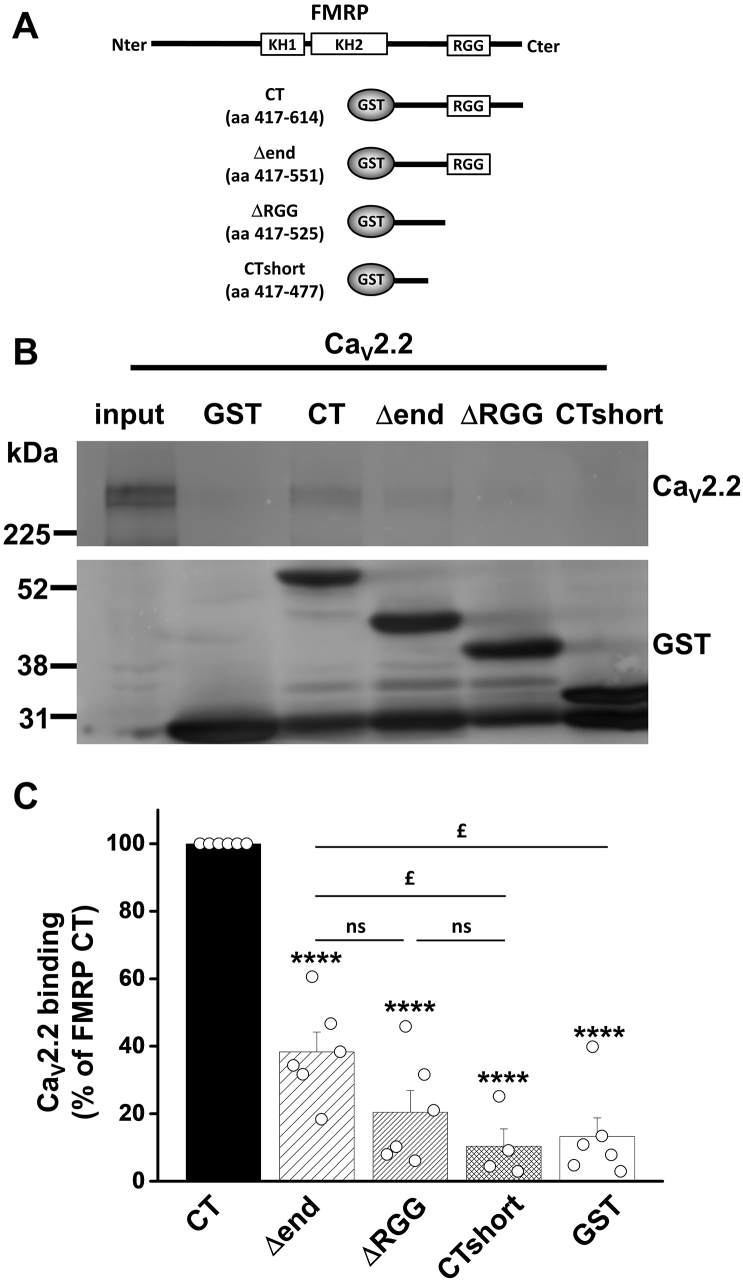
Distal FMRP C-terminus interacts with CaV2.2.A) Schematic depiction of FMRP and GST-fusion fragments used for pull-down assay. Nter, N-terminus; Cter, C-terminus; KH1 and KH2, K-homology domains 1 and 2; RGG, arginine-glycine-glycine motif; aa, amino acid; CT, GST-FMRP C-terminus; Δend, GST-FMRP C-terminus deleted from the last 63 amino acids; ΔRGG, GST-FMRP C-terminus deleted from the last 89 amino acids which includes the RGG motif; CTshort, GST-FMRP C-terminus deleted from the last 137 amino acids.B) Western blots of pull-down assays show FMRP C-terminus binding CaV2.2 expressed in tsA-201 cells compared with several deletant mutants for FMRP C-terminus and GST alone. Top panel shows immunoblots with CaV2.2 II-III loop Ab. Lower panel shows immunoblots with GST Ab. Input represents 5% of protein input included in the assay. Representative of more than 4 independent experiments.C) Binding of CaV2.2 expressed as a percentage of FMRP C-terminus (CT). Serial deletions of FMRP C-terminus resulted in 61.7 ± 5.8% (n = 6), 79.5 ± 6.4% (n = 6), 89.6 ± 5.1% (n = 4) and 86.7 ± 5.5% (n = 6) reductions of the binding for Δend, ΔRGG, CTshort and GST, respectively. n numbers correspond to independent experiments. Open black circles represent individual experiments. **** P < .0001 compared with CT, £P < .05, ns: not significant, one-way ANOVA and Bonferroni post-hoc test.